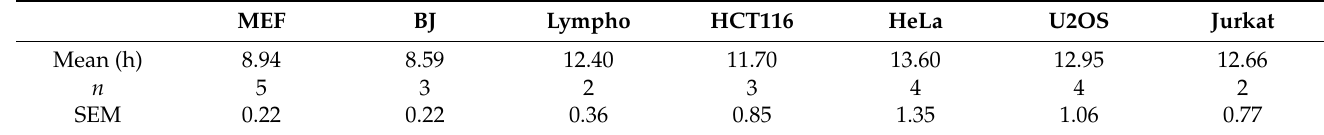
Table 1. Measured duration of S phase in normal and cancer cell lines.